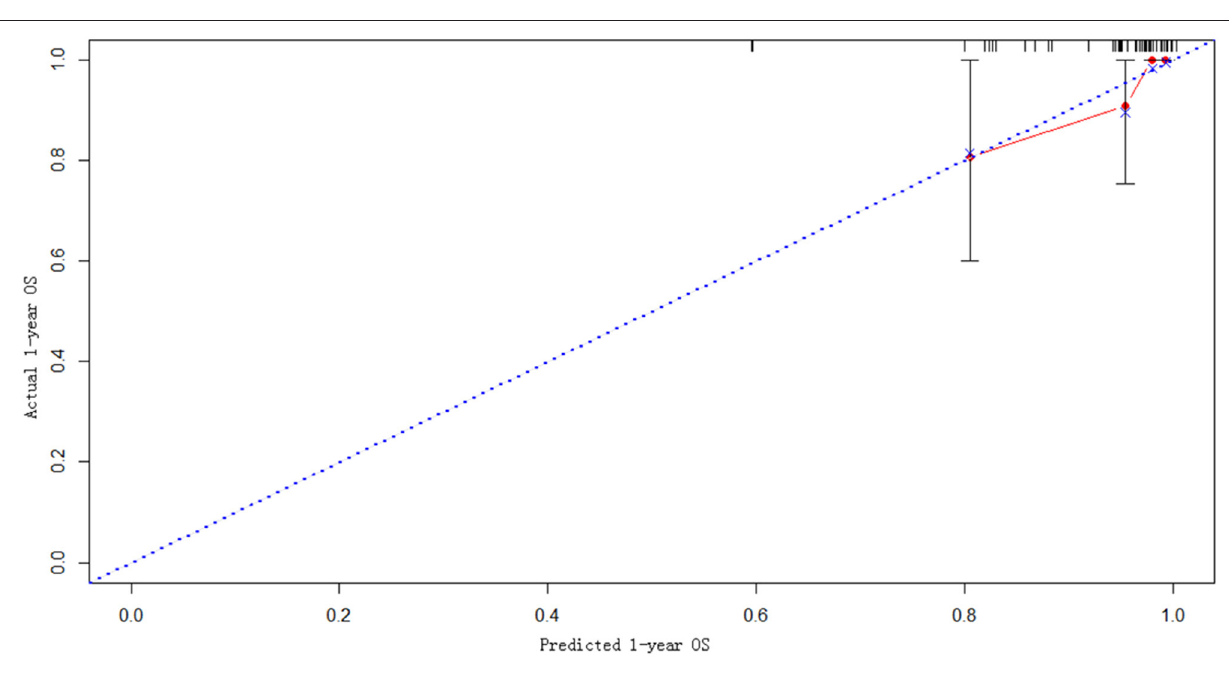
FIGURE 6 | Calibration curves for 1-year prediction in the validation